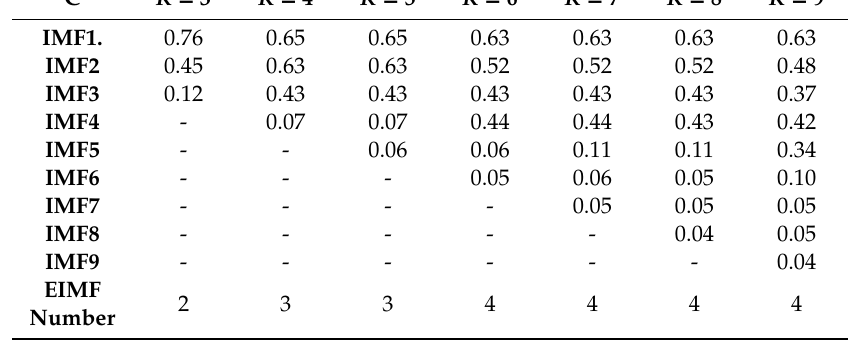
Table 1. The correlation coefficient between intrinsic mode functions (IMFs) and the original signal. C K =3 K =4 K =5 K =6